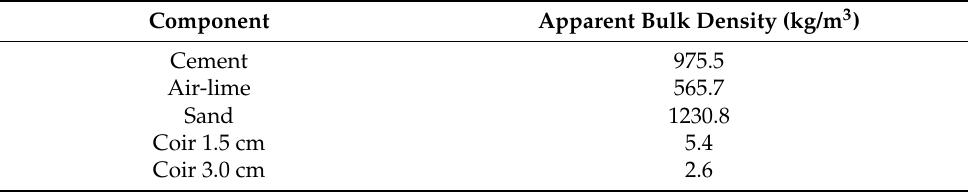
Table 1. Bulk density of the constituents.